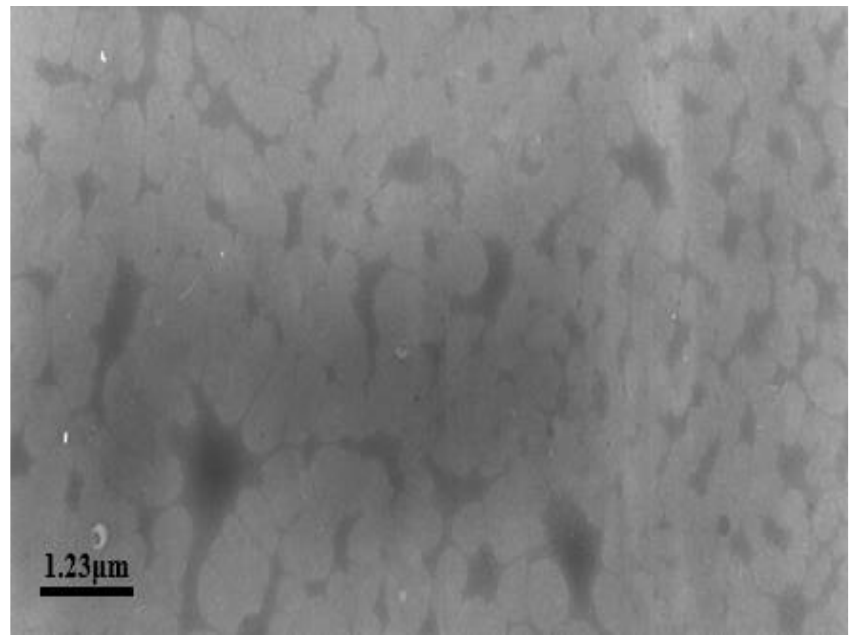
Figure 11. Micro-structure of the drag reducer after being subjected to high rate of flow shear.